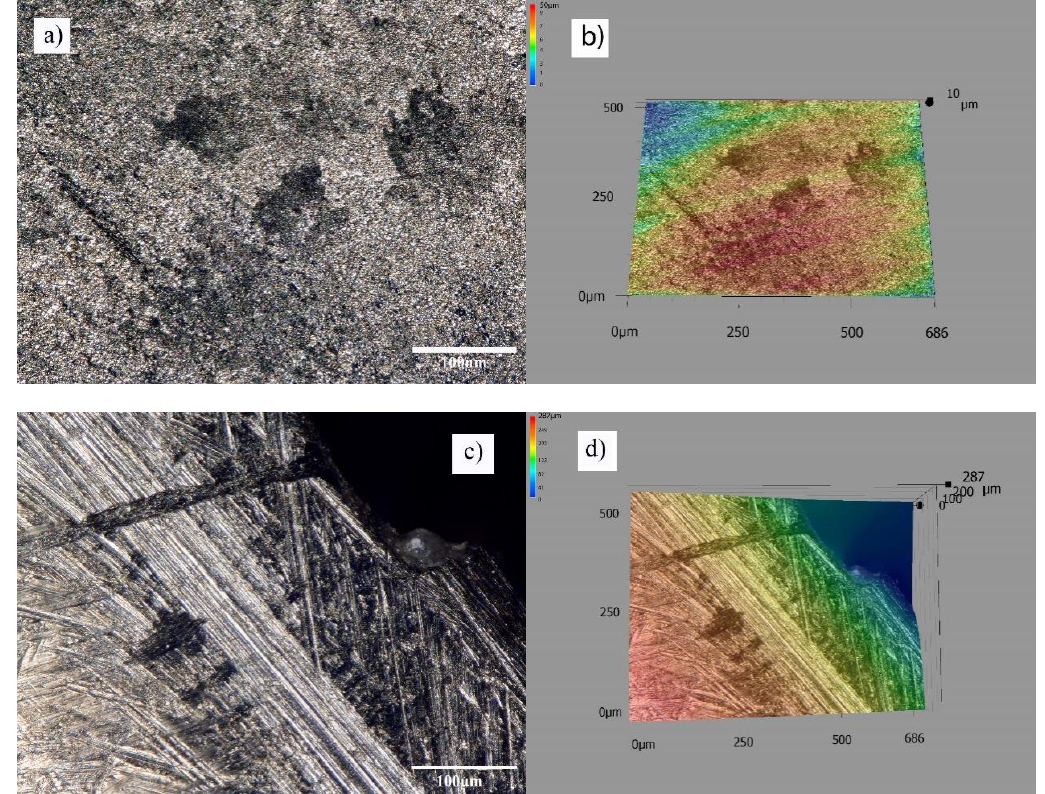
Figure 17. Image of wear of the artificial joint after 12 years of use, a) material losses, b) material losses 3d view, c) frictional wear, d) frictional wear3d view.